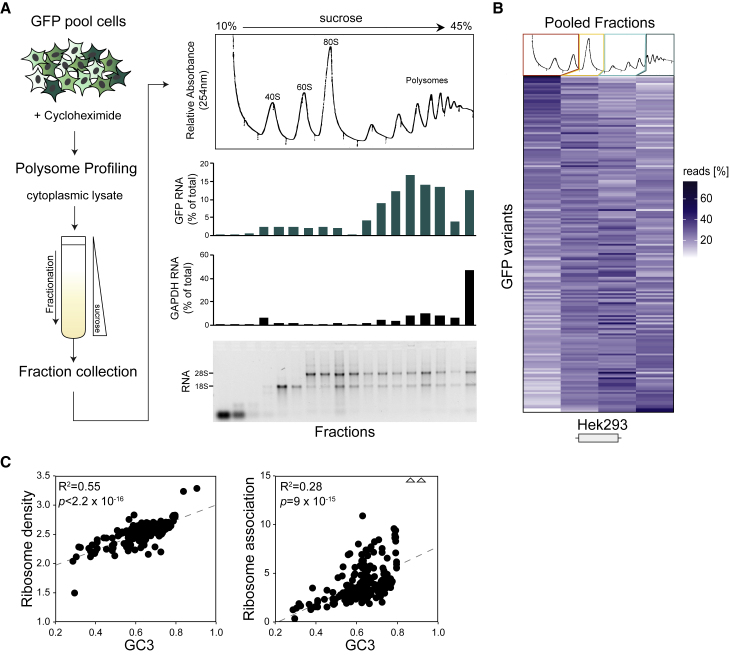
High GC Content Leads to Increased Ribosome Association(A) On the left, a stable pool of HEK293 cells expressing 217 unspliced GFP variants was subjected to polysome profiling using sucrose gradient centrifugation. On the right, from top to bottom, is a UV absorbance profile, GFP mRNA abundance, GAPDH mRNA abundance, ethidium bromide staining of gradient fractions. GFP and GAPDH mRNA were quantified by qRT-PCR.(B) RNA from collected fractions was combined into four pools (as indicated by colored boxes) before amplicon library preparation for high-throughput sequencing: unbound ribonucleoprotein complexes (red), monosomes (yellow), light polysomes (light green), and heavy polysomes (dark green). Resulting read distributions (in %) for GFP variants are represented as heatmap.(C) Correlation plot between mean ribosome density (left) and ribosome association (right) of GFP variants and their corresponding GC3 content. Triangles indicate outliers (ribosome association values 24.89 [GC3 = 0.84] and 24.80 [GC3 = 0.90]). The ribosome density and ribosome association measures were calculated as described in the STAR Methods section.